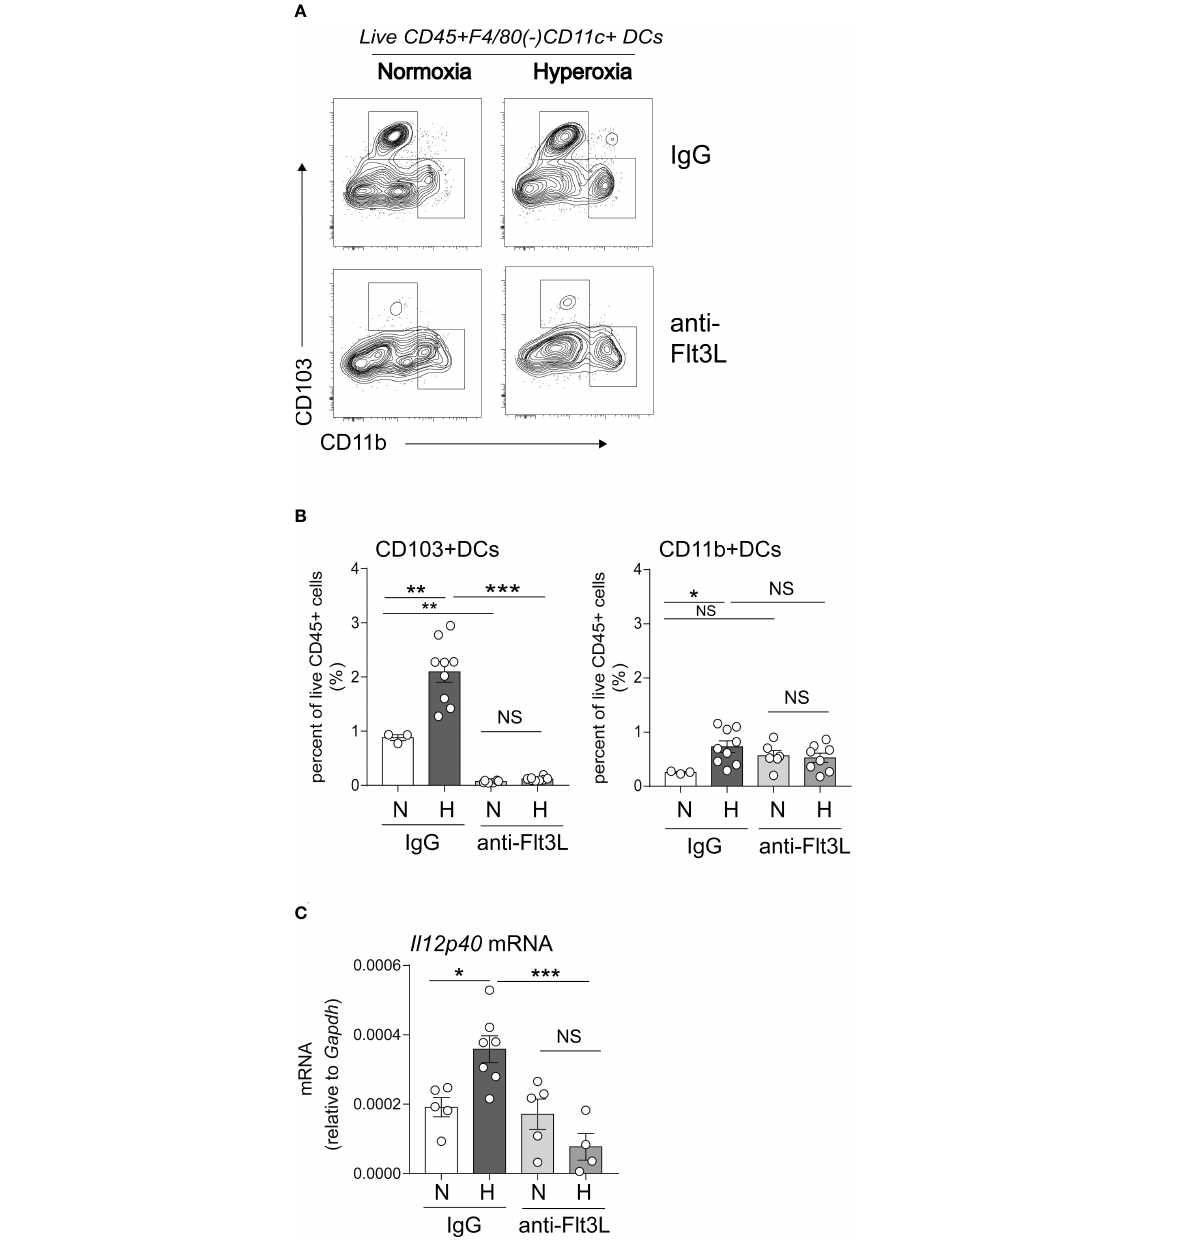
FIGURE 5 In vivo blockade of Flt3L with anti-Flt3L reduces the number of CD103+ DCs in neonatal lung and attenuates the hyperoxia-induced IL-12p40 expression. (A, B) . Two-day-old mice were exposed to normoxia or hyperoxia and treated with IgG or anti-Flt3L once daily. After 11 days of hyperoxia exposure and daily anti-Flt3L treatment, total lung CD103+ DCs and CD11b hi DCs were determined and quanti fi ed by fl ow cytometry. Anti-Flt3L not only blocked hyperoxia induced CD103+ DCs numbers in lung but also blocked CD103+ DCs in nomoxic condition. On the other hand, Anti-Flt3L only blocked hyperoxia induced CD11b hi DCs in lung. (C) . In some experiments, IL12p40 mRNA expression was measured in whole lung homogenates. Anti- Flt3L blocked hyperoxia-induced IL12p40 mRNA expression in neonatal lung. These results are representative of two independent experiments. Signi fi cant levels were indicated by * P <0.05, ** P <0.01, *** P <0.001 (one-way ANOVA), NS, non-signi fi